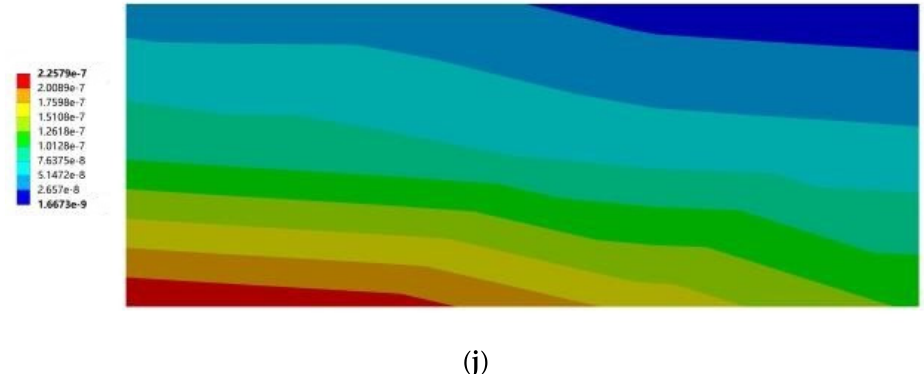
Figure 18. Cloud diagram of the maximum elastic principal strain of southward horizontal sun visors. ( a ) South to southeast wind. ( b ) South to northwest wind. ( c ) South by west 15 to southeast wind. ( d ) South by west 15 to northwest wind. ( e ) South by west 30 to southeast wind. ( f ) South by west 30 to northwest wind. ( g ) South by east 15 to southeast wind. ( h ) South by east 15 to northwest wind. ( i ) South by east 30 to southeast wind. ( j ) South by east 30 to northwest wind. Figures 19 and 20 show the maximum principal elastic strain cloud diagrams of the southward horizontal sunshades with different building orientations under two wind conditions. When the most strained part appears below, it means that the root of the lower surface of the horizontal sun visor was stressed; when the most strained part appears on the top, it means that the root of the horizontal sun visor was stressed.